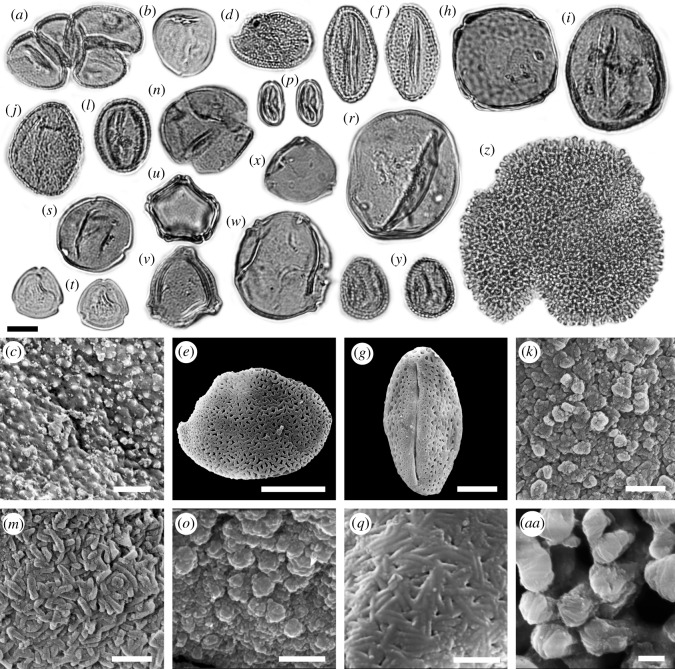
LM and SEM micrographs of Poales, Vitales, Rosales, Fagales, Malpighiales and Geraniales. (a) Typha sp./Tetradomonoporites typhoides, tetrad, PV. (b,c) Poaceae gen. indet., EV, (c) exine detail, PRV. (d,e) Monocotyledonae indet., (d) PV, (e) PRV. (f–g) Parthenocissus sp., EV. (h) Ulmus vel Zelkova sp., PV. (i) Fagus sp., EV. (j,k) Quercus sect. Cerris sp., EV, (k) SEM detail, mesocolpium exine sculpturing. (l–m) Quercus sect. Ilex sp., EV, (m) SEM detail, mesocolpium exine sculpturing. (n,o) Quercus sect. Quercus sp., PV, (o) SEM detail, apocolpium exine sculpturing. (p,q) Castaneoideae gen. indet., EV, (q) SEM detail, mesocolpium exine sculpturing. (r) Carya sp., PV. (s) Platycarya sp., PV. (t) Engehardioideae gen. indet., PV. (u) Alnus sp., PV. (v) Betula sp., PV. (w) Carpinus sp., PV. (x) Corylus sp., PV. (y) Salix sp., EV. (z–aa) Geranium sp., (z) PV, (aa) clavae detail. Equatorial view (EV), polar view (PV), proximal view (PRV). Scale bars 10 µm (LM, e,g), 1 µm (c,k,m,o,q,aa).